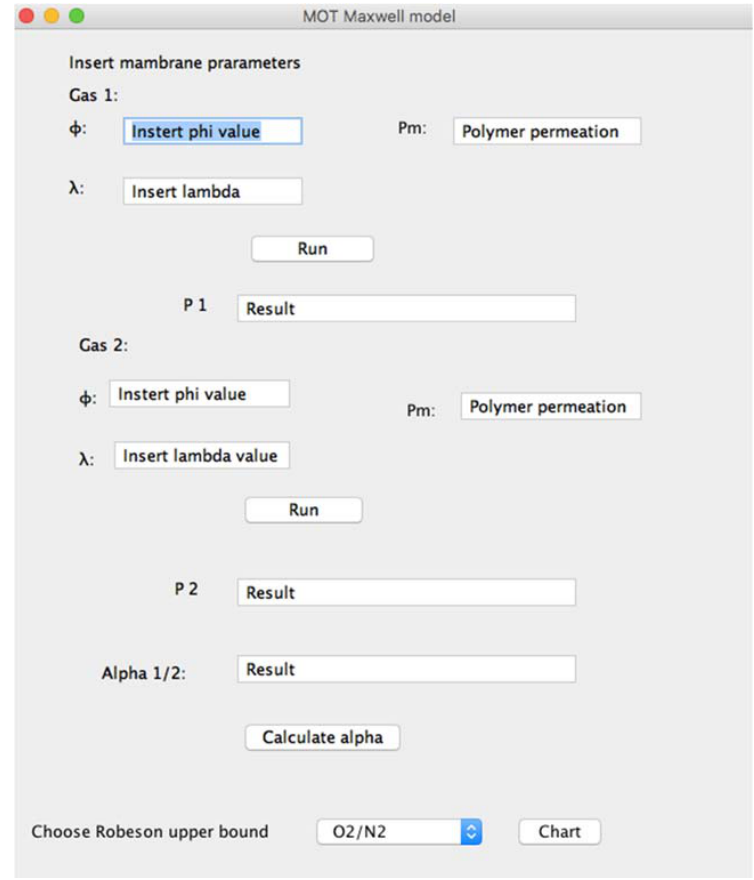
Figure 3. Maxwell’s model window.